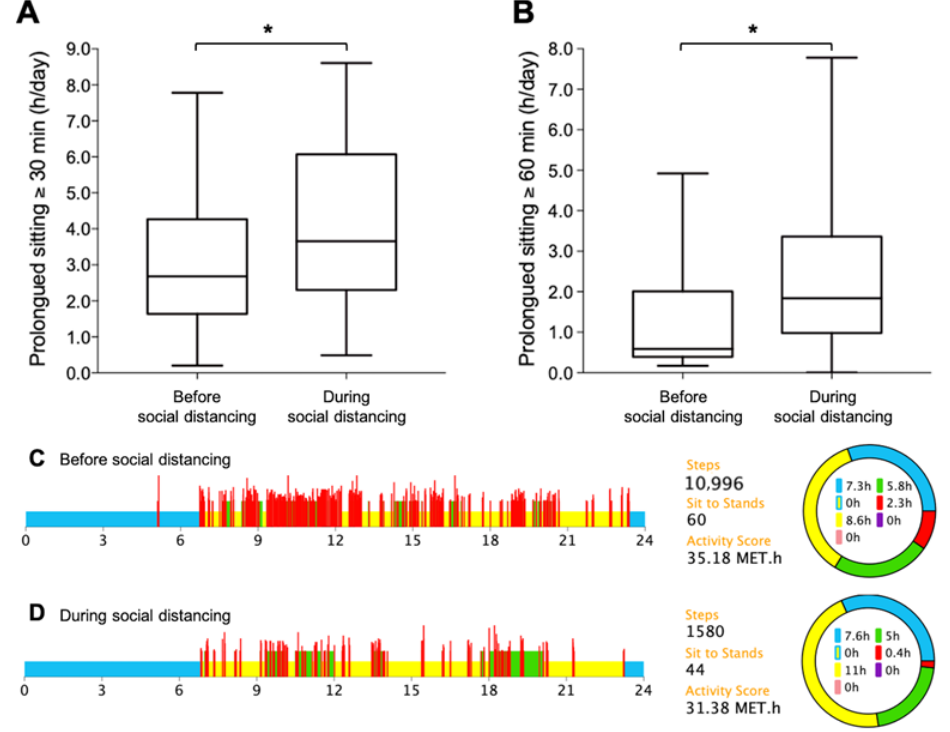
Figure 1. Prolonged sitting and physical activity in rheumatoid arthritis. Panels ( A ) and ( B ) depict total time spent in prolonged sitting ≥ 30 min and ≥60 min ( n = 35). In the bottom, illustrative data showing the fall in activity and the rise in prolonged sitting in a rheumatoid arthritis patient as- sessed before (Panel C ) and during the social distancing (Panel D ). Legend: blue, sleeping time; yellow, sedentary time; green, standing time; red, stepping time (irrespective of intensity); * p <